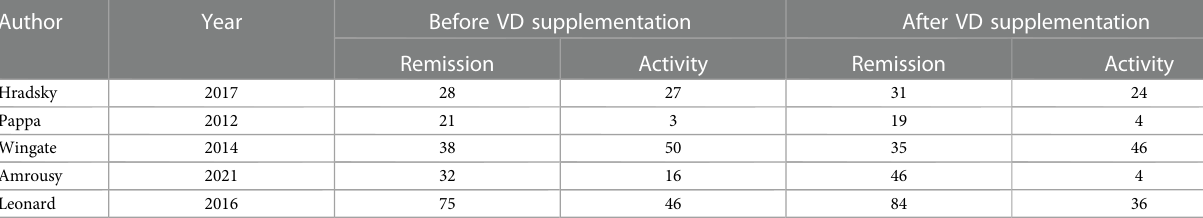
Leonard VD, vitamin D; IBD, in fl ammatory bowel